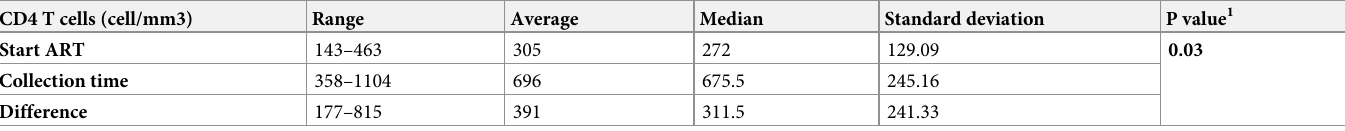
Table 5. Analyses of CD4